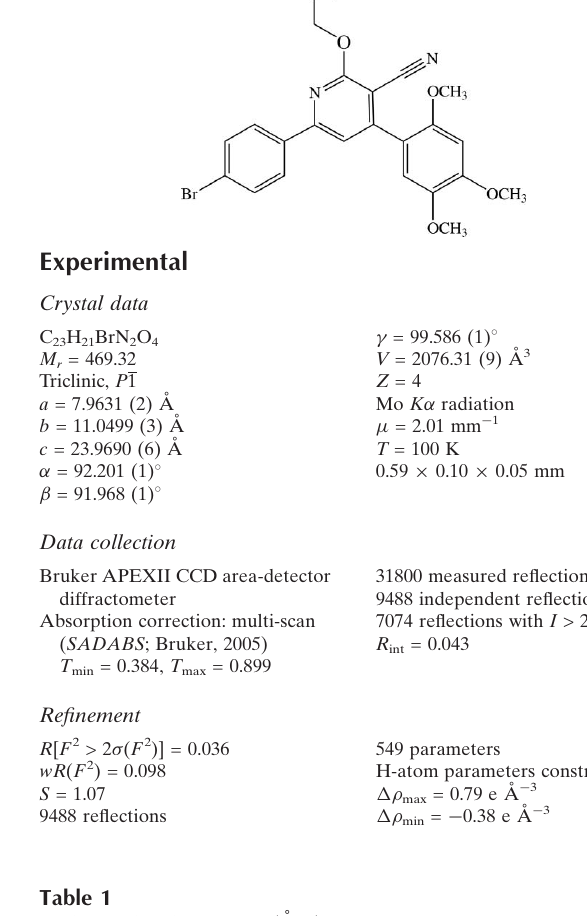
Hydrogen-bond geometry (A˚ , (cid:3)